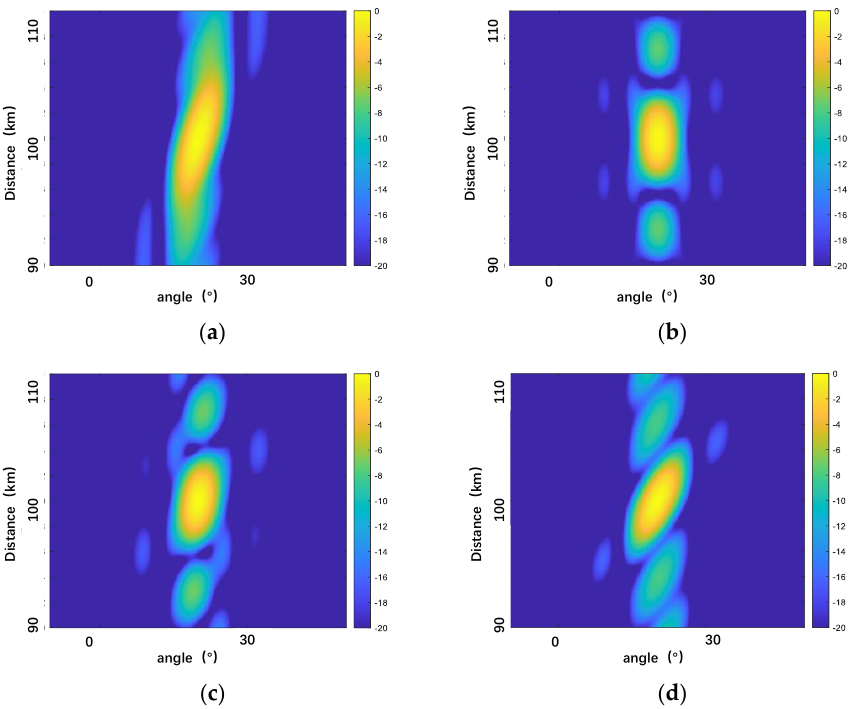
Figure 4. Equivalent transmitting antenna beams of the four schemes: ( a ) Log-FDA; ( b ) Ham-FDA; ( c ) HL-FDA; and ( d ) Proposed.